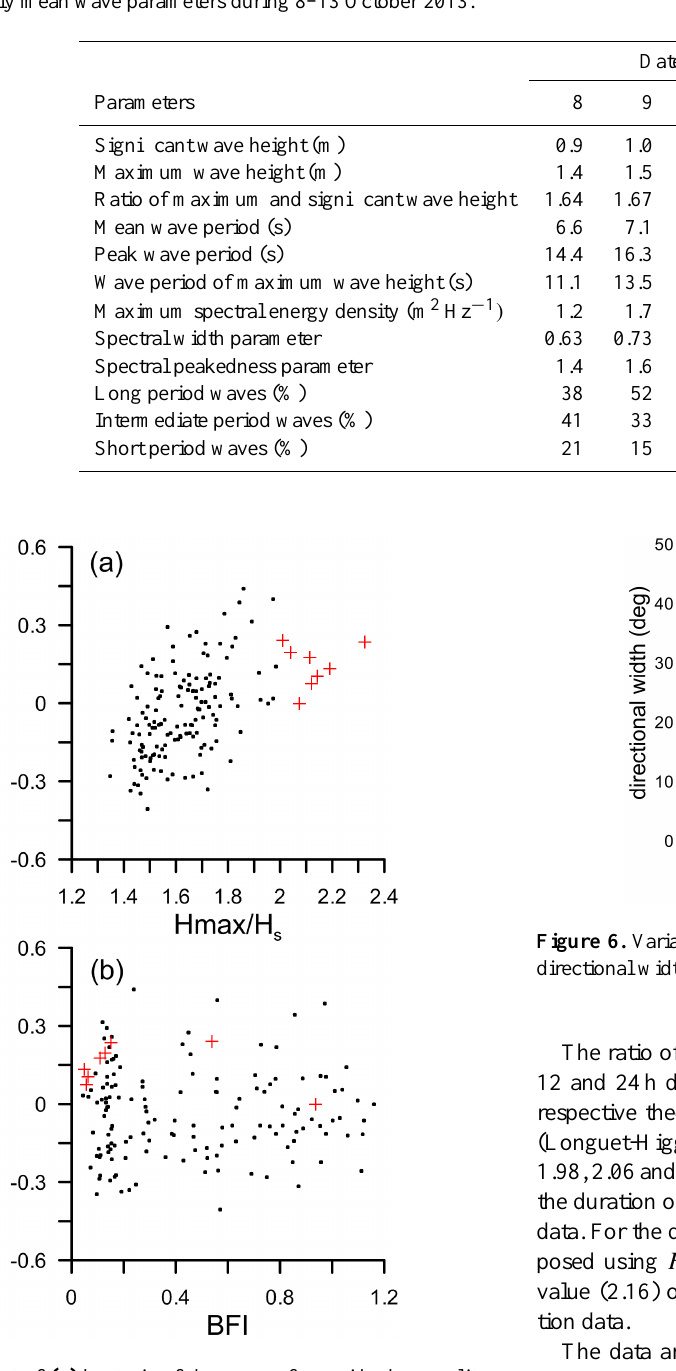
Figure 5. Plot of (a) kurtosis of the sea surface with abnormality index ( H max /H s ) and (b) kurtosis of the sea surface elevation with Benjamin–Feir index (BFI). The data of the freak waves are indi- cated with cross symbols.